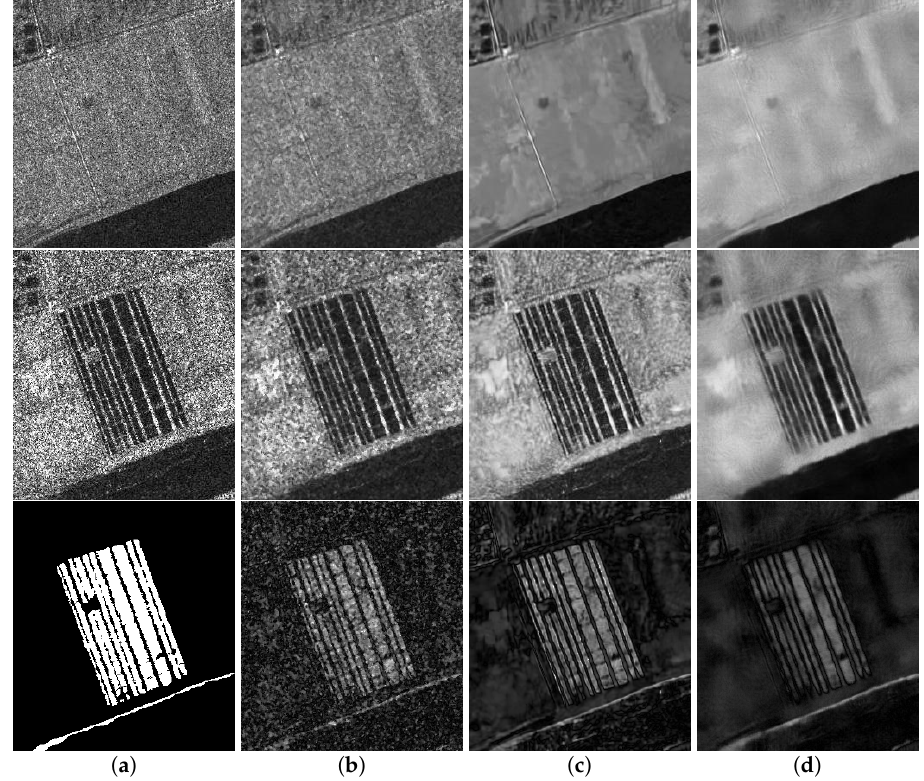
Figure 3. Yellow River Set A. ( a ) Raw images from June 2008 and June 2009 and reference map. ( b – d ) Filter images by MMSE, SAR-BM3D, PPB, and the corresponding